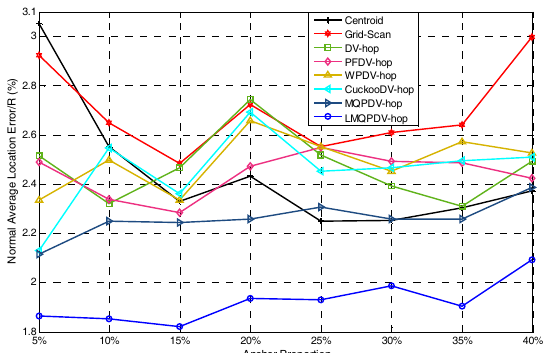
Figure 12. Communication range 200 for WSN#2.